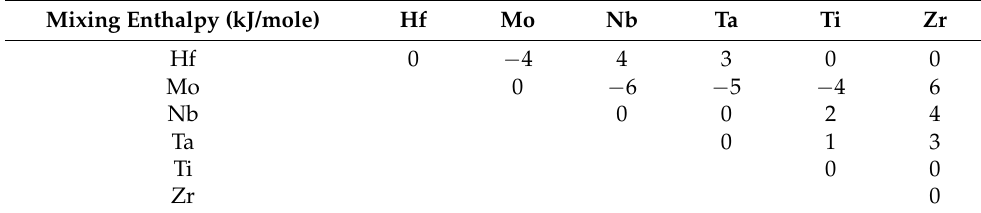
Table 2. Mixing Enthalpies Between The Constituent Metallic Elements of RHEA